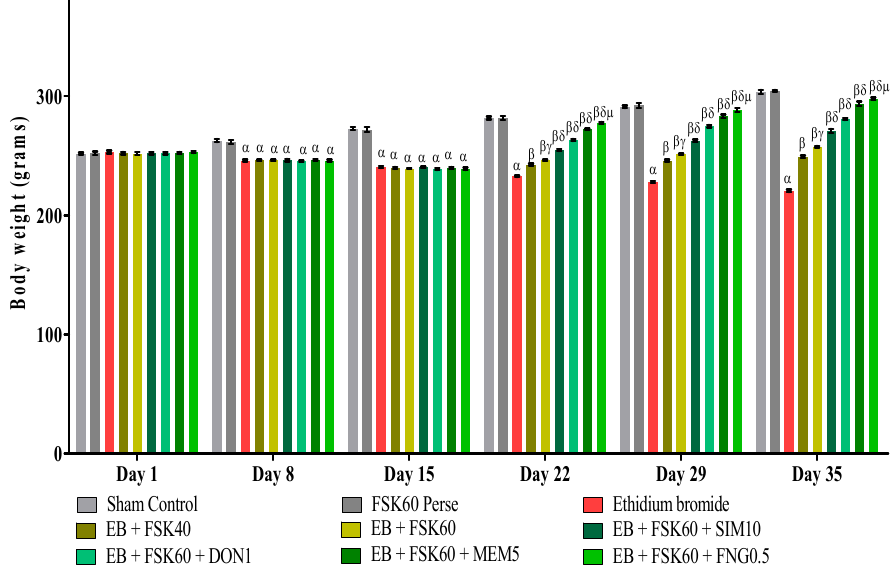
Figure 2. Protective role of FSK on body weight in experimental multiple sclerosis rats. Analysis of Variance (ANOVA) with Bonferroni’s post hoc test was used to evaluate the data, which were presented as mean with SD ( n = 6). α EB (p < 0.01) v / s Sham control and FSK40 perse; β EB + FSK40, EB